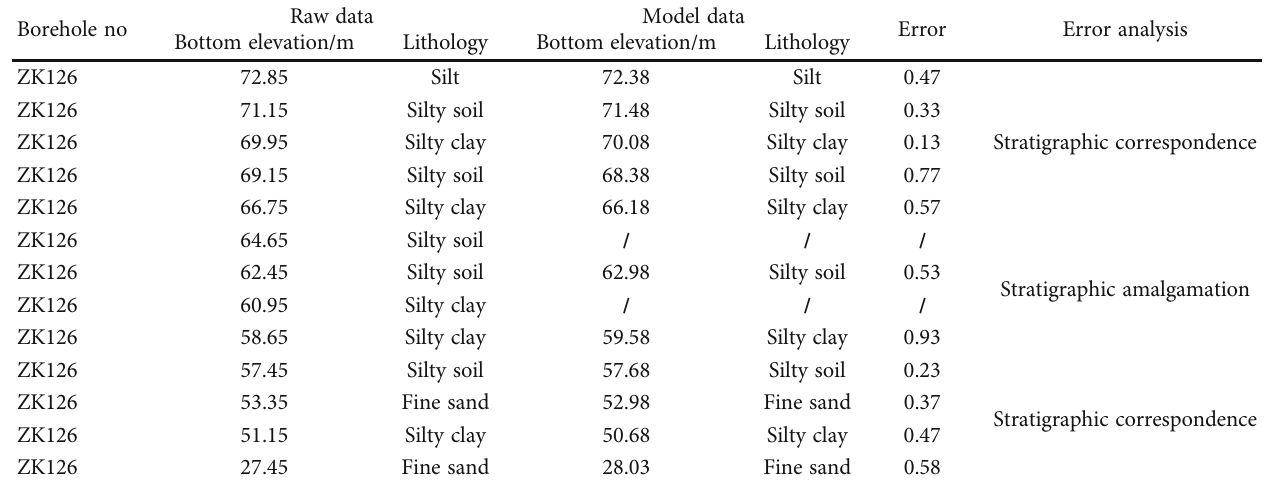
Figure 10: Lens between two layers. Table 3: Borehole veri fi